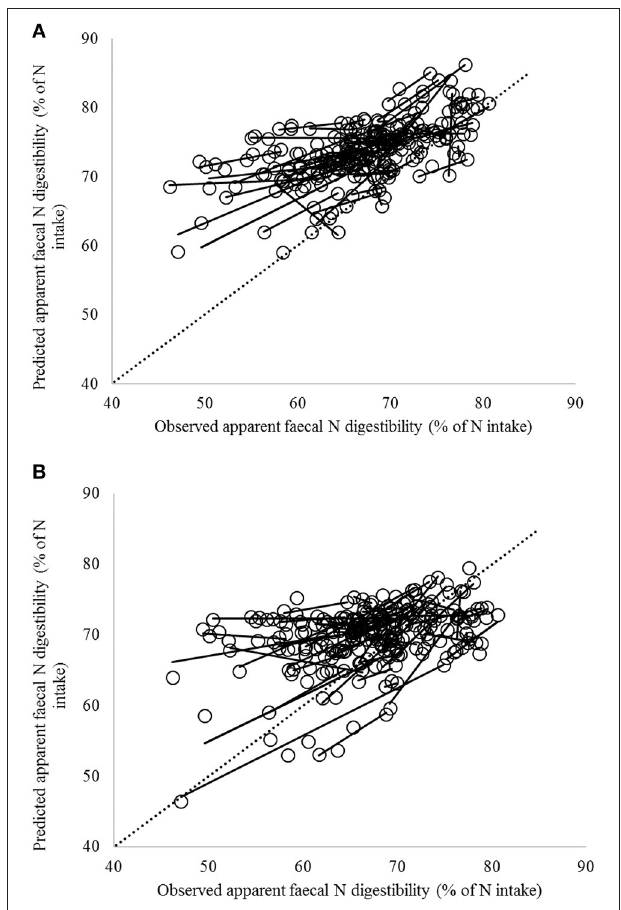
FIGURE 2 | Comparison of observed and predicted apparent fecal N digestibility values according to (A) the CVB model (the current Dutch feed evaluation system of net energy of lactation; Van Es, 1978) and (B) the enteric methane emission Tier 3 model (Bannink et al., 2011) for the complete dataset with observations for lactating cows from 58 trials including 242 dietary treatments. Solid lines indicate regression of predicted against observed values within trial; the dashed line indicates the line of